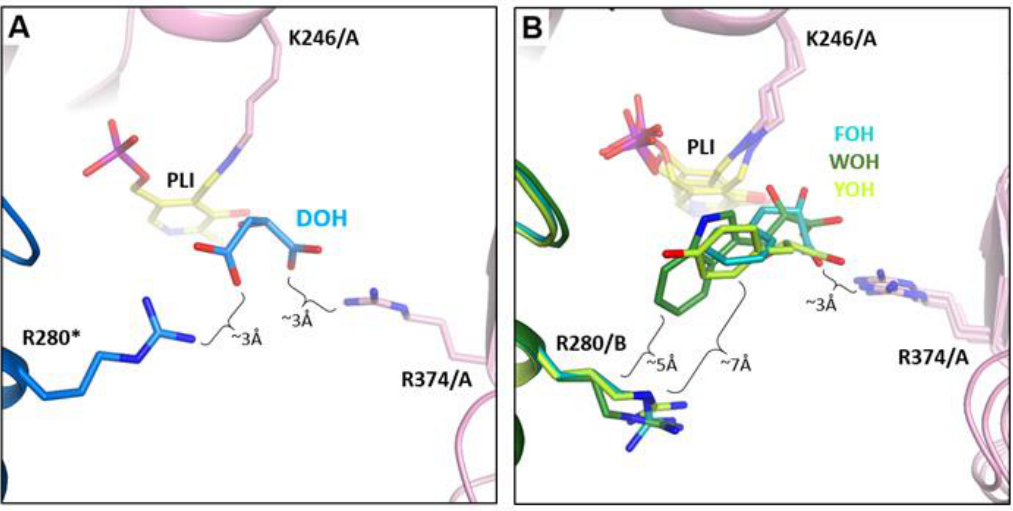
Figure 7. Arginine (Arg280*) “switch”; ( A ) in “up” position in Psy ArAT/DOH and ( B ) in “down” position in Psy ArAT/FOH, Psy ArAT/YOH and Psy ArAT/WOH complexes.